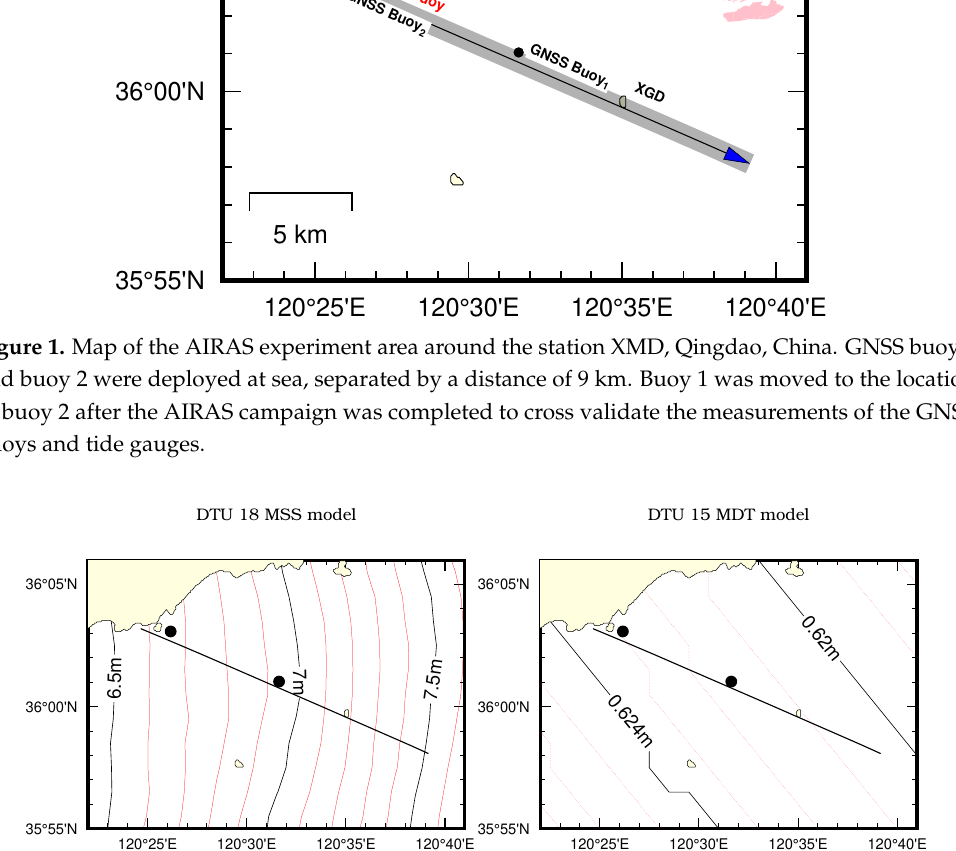
Figure 2. The mean sea surface (MSS) and mean dynamic topography (MDT) models over the campaign sea area. Black points represent the GNSS buoy locations; the black line represents the flight path. Two GNSS buoys, separated by a distance of 9 km, were deployed in the sea area of the AIRAS observation, which provided 1-Hz SSH data. After completion of the AIRAS campaign, GNSS buoy 1 was moved by ship to the location of buoy 2 to conduct cross validation of the buoys. In addition, tide gauge, wave buoy, and weather station data were also collected during this campaign. All these data helped with evaluation of the sea state conditions and provided suitable filters for the GNSS buoy